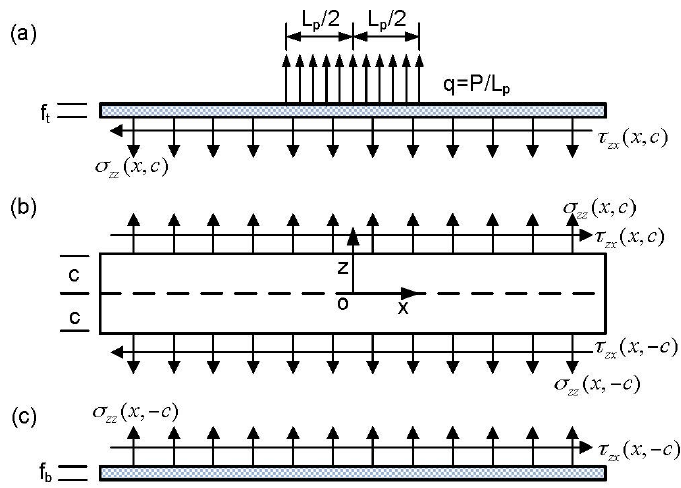
Figure 2. Sketch of the top face, bottom face and the core of a sandwich panel. ( a ) top face; ( b ) core; ( c ) bottom face.